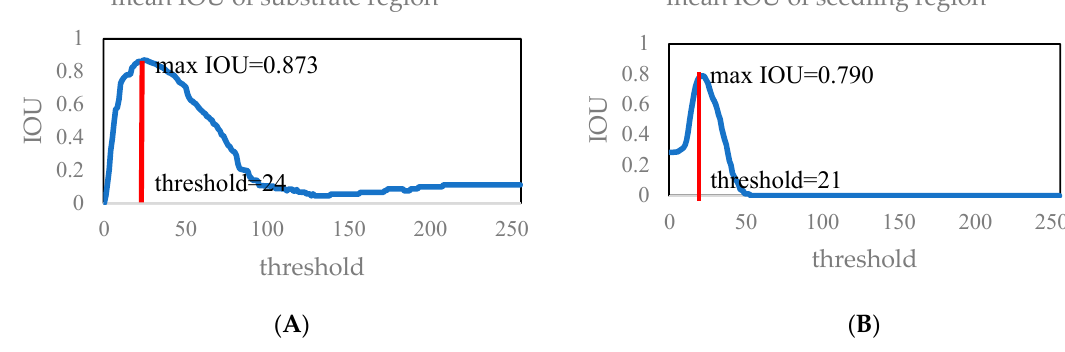
Figure 11. Mean IOU of the substrate ( A ) and seedling region ( B ).